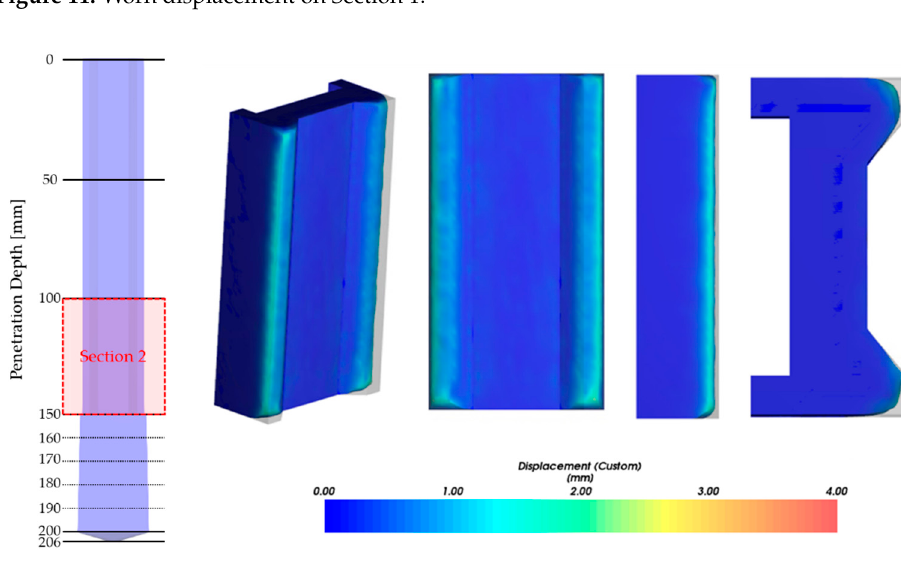
Figure 12. Worn displacement on Section 2.